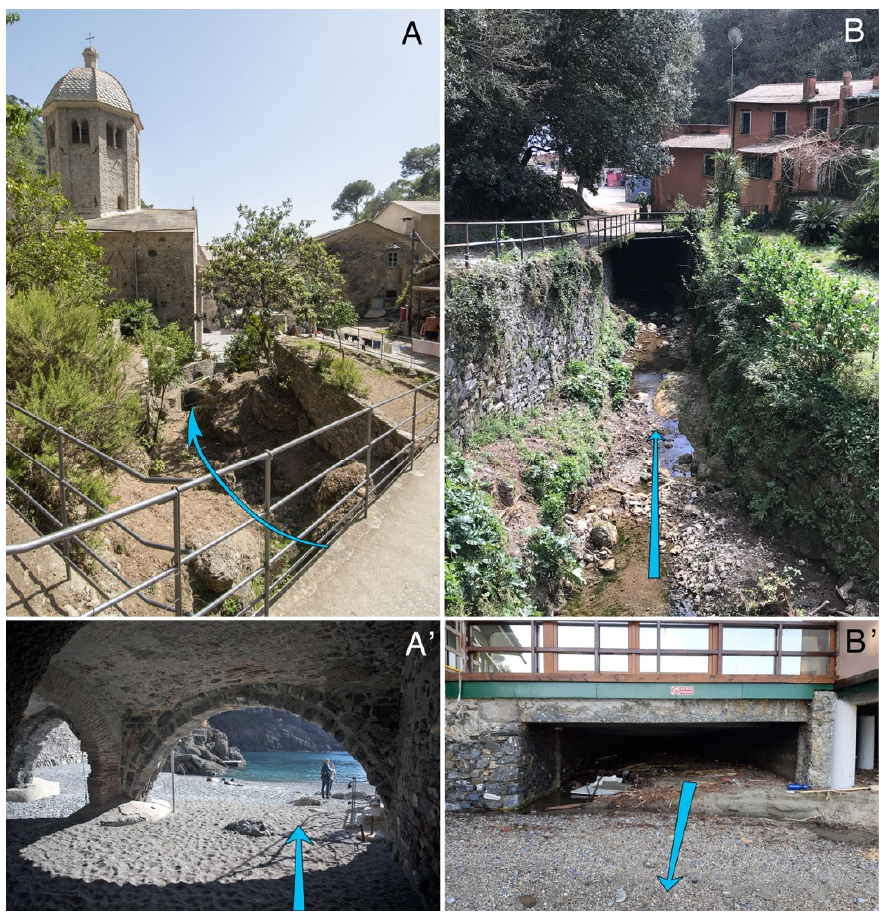
Figure 9. Culvert inlets ( A , B ) and outlets ( A’ , B’ ) at the stream mouth in catchment n. 2 for A–A’ and catchment n. 5 for B–B’.